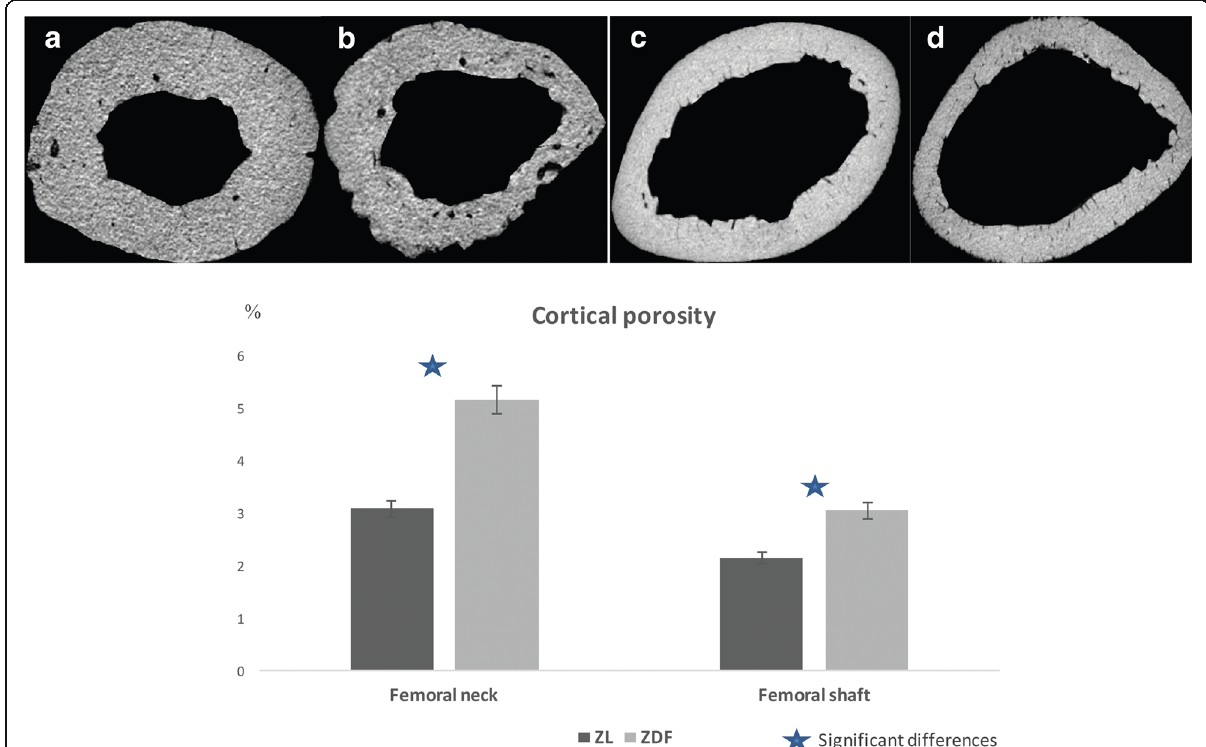
Fig. 3 Comparison of cortical porosity between a Zucker diabetic fatty (ZDF) rat and a Zucker lean ZL rat. Axial images of the femoral neck of ZL ( a ) and ZDF ( b ) rats, and the femoral shaft of ZL ( c ) and ZDF ( d ) rats. Cortical porosity was higher in ZDF compared to ZL rats, in the two locations